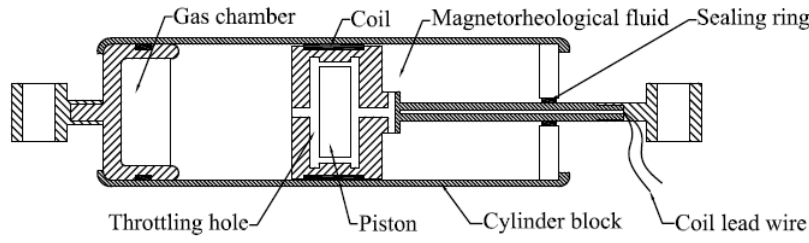
Figure 2. The structure of magnetorheological damper. MRF dampers use a smart material, magnetorheological fluid (MRF), that can change the damping force by changing the magnetic field [17]. Without a magnetic field, the magnetic particles in the MRF are distributed in the base liquid in a disordered state; shear stress is only related to the shear rate, and the MRF can be regarded as a Newtonian fluid. In the presence of a magnetic field, the magnetic particles condense into a chain structure along the direction of the magnetic field, causing the whole suspension system to produce a phase change that causes the stress force of the MRF to increase with an increase in the magnetic field. When the magnetic field is withdrawn, the MRF returns to a Newtonian fluid state